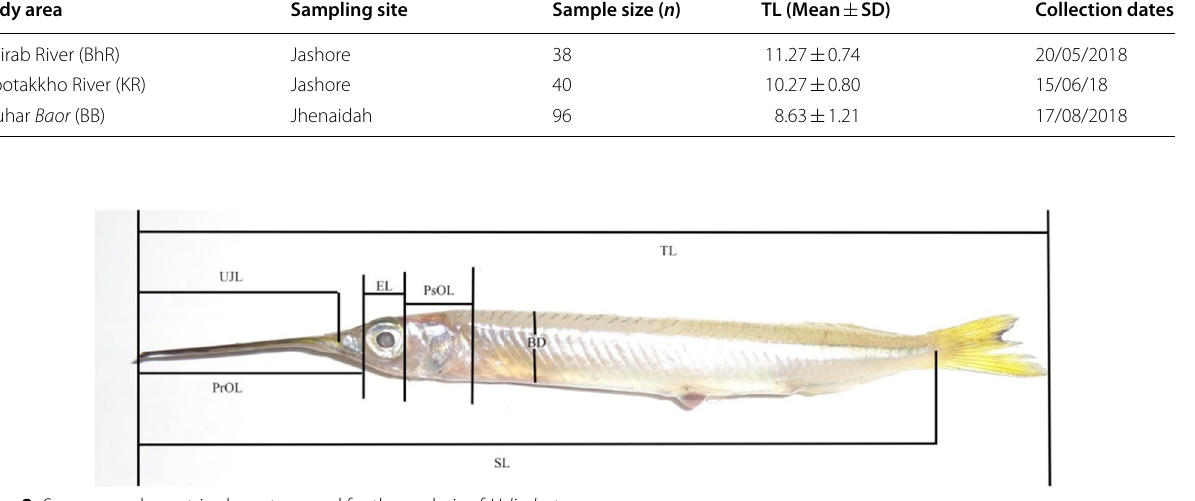
Fig. 2 Seven morphometric characters used for the analysis of H. limbatus